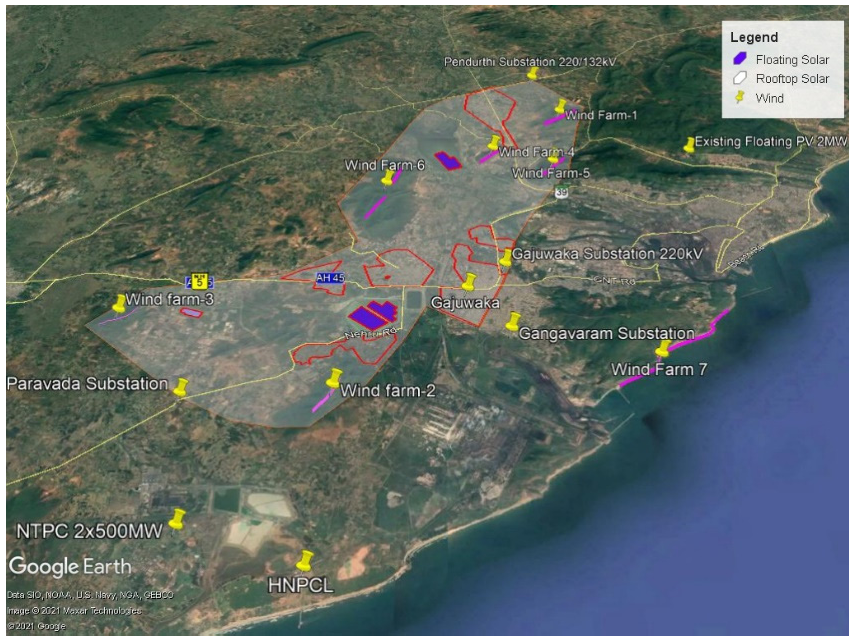
Figure 5. Identification of potential areas for renewable energy plant installations using Google Earth Pro.